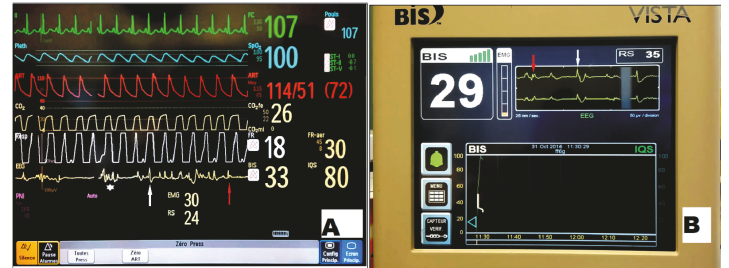
Figure 1: PANEL A: 2 channels sensors (BIS Quatro) connected to a Philips module: real time EEG shows polyspikes (white star), spikes (white arrow), and spike-wave (red arrow). IQS = signal quality index. RS= suppression ratio. PANEL B: 2-channel sensor (BIS Quatro) connected to a BIS VISTA module: real time EEG shows spike-wave (red arrow) and spike (white arrow). IQS = signal quality index. RS= suppression